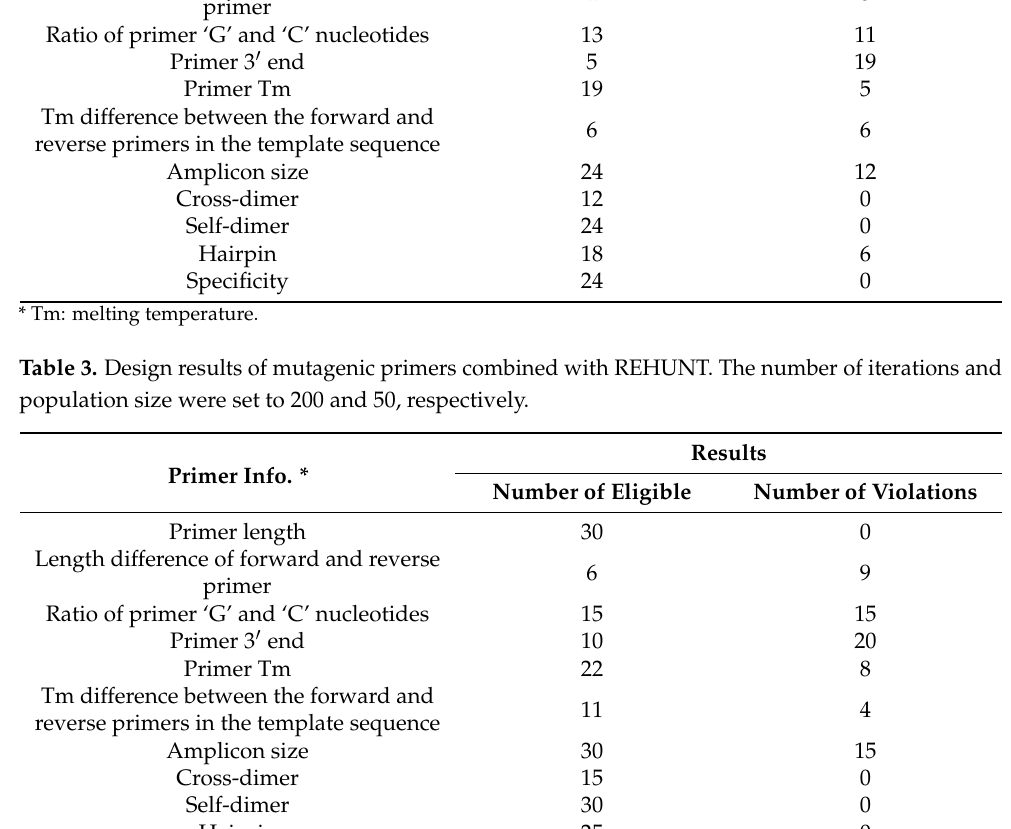
Table 2. Design results of mutagenic primers combined with REHUNT. The number of iterations was set to 100 and the population size was set to 50. Results Primer Info. * Number of Eligible Number of Violations Primer length 24 0 Length difference of forward and reverse 4 8 primer Ratio of primer ‘G’ and ‘C’ nucleotides